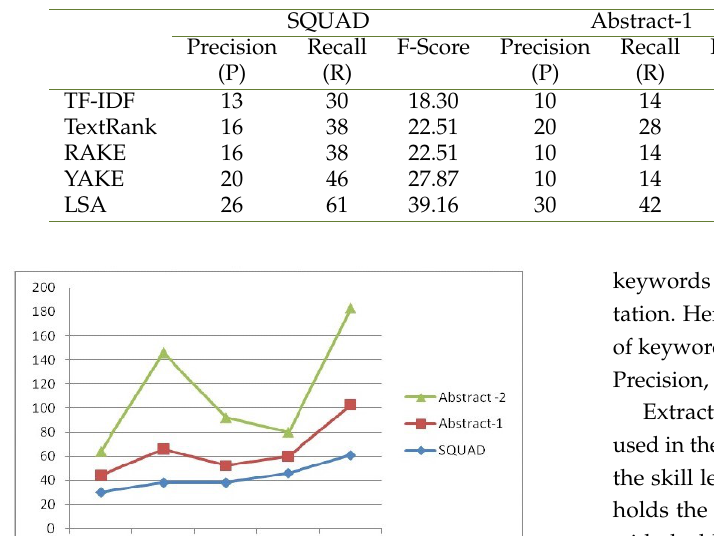
Table 5. Experimental